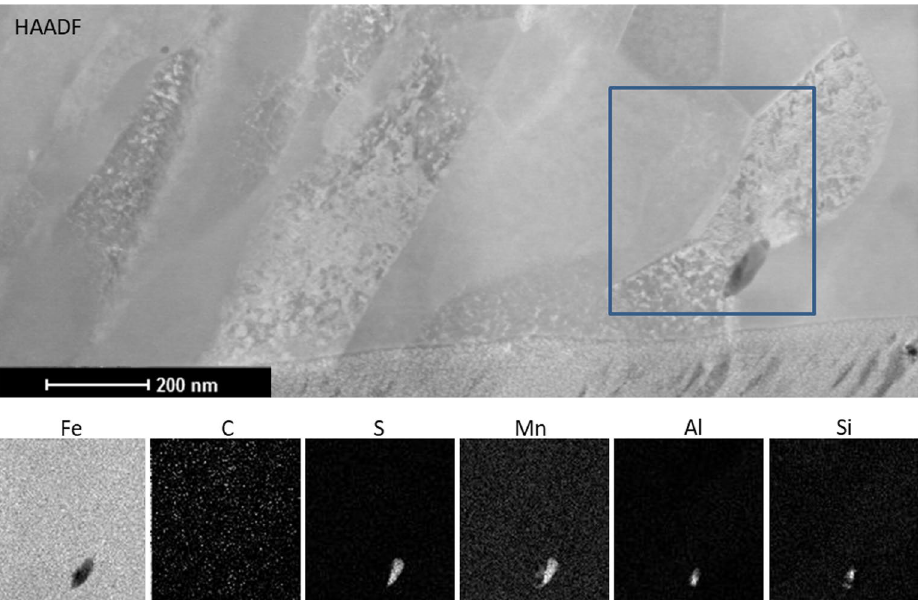
Figure 2. STEM-HAADF image of the DRX area (top). EDX chemical maps (bottom row) of the square in the HAADF image depict the distribution of Fe, C, S, Mn, Al and Si. C is equally distributed and does not show excess neither in the inclusion nor in the grain boundaries. Elements typical for impurities in commercial steels constitute the